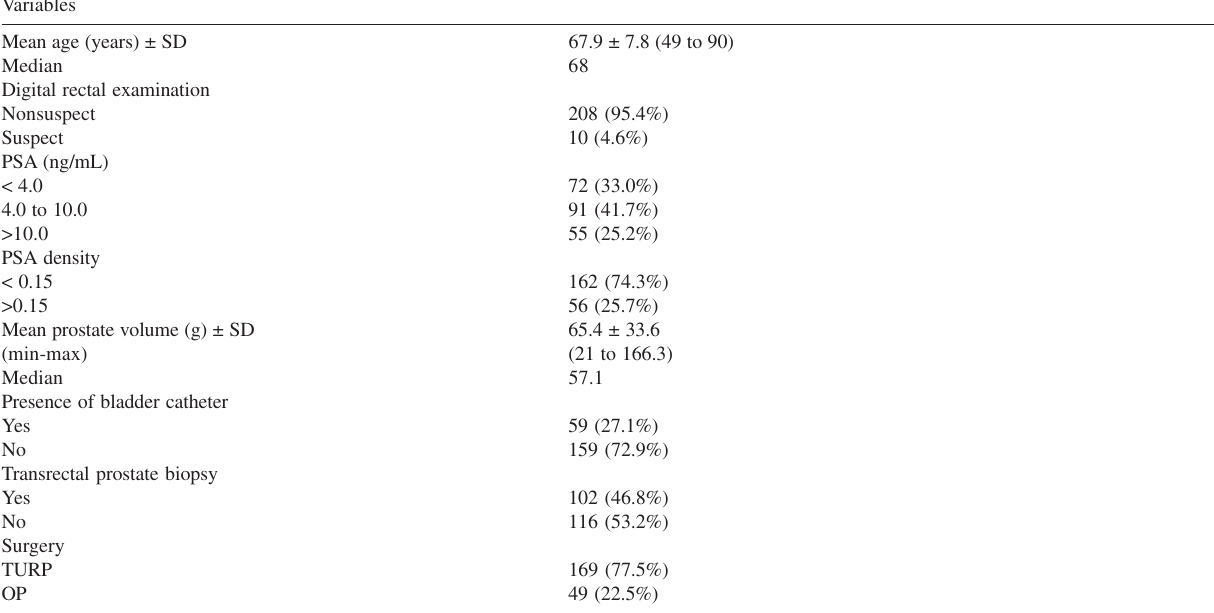
Table 1 - Preoperative characteristics of the patients